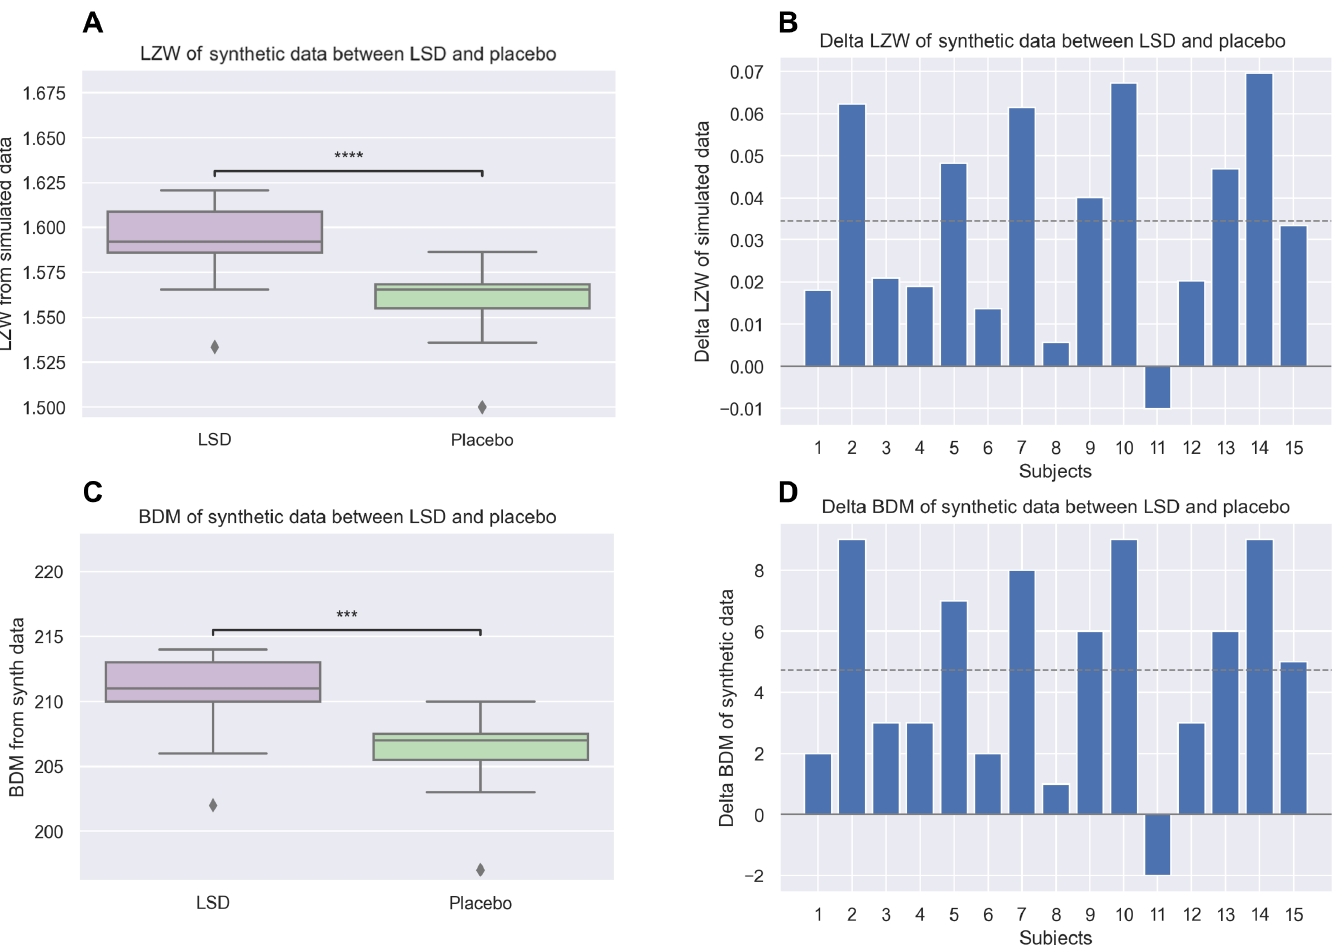
Fig 5. Individual shift of LZW (top row) and BDM (bottom) complexity in LSD and placebo conditions estimated from synthetic data generated by the archetype model. Here we derive complexity estimates from synthetic data generated by the individualized archetype models for each subject. A, C : Box plots of the metrics for each subject under the effect of LSD and placebo. B, D : Bar plot of the differences in metrics between LSD and placebo for each subject. The dashed line represents the mean of the metric (three stars: p < 0.001, four stars: p < 0.0001).